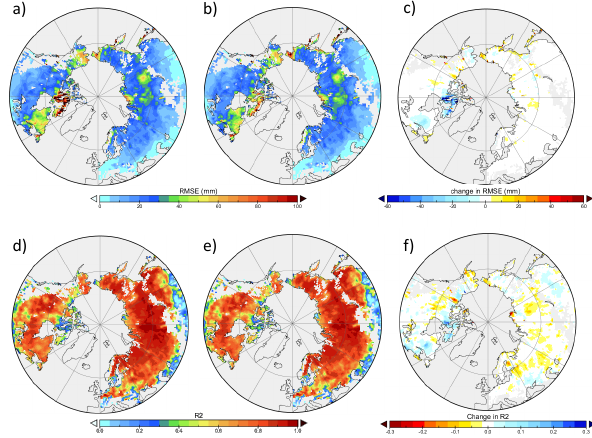
Figure 10. Effect of assimilation on agreement with GlobSnow snow water equivalent estimates, showing (a–c) root mean square error (RMSE) and (d–f) the coefficient of correlation ( R 2 ). From left to right, agreement for (a, d) prior and (b, e) posterior estimates as well as (c, f) the change in